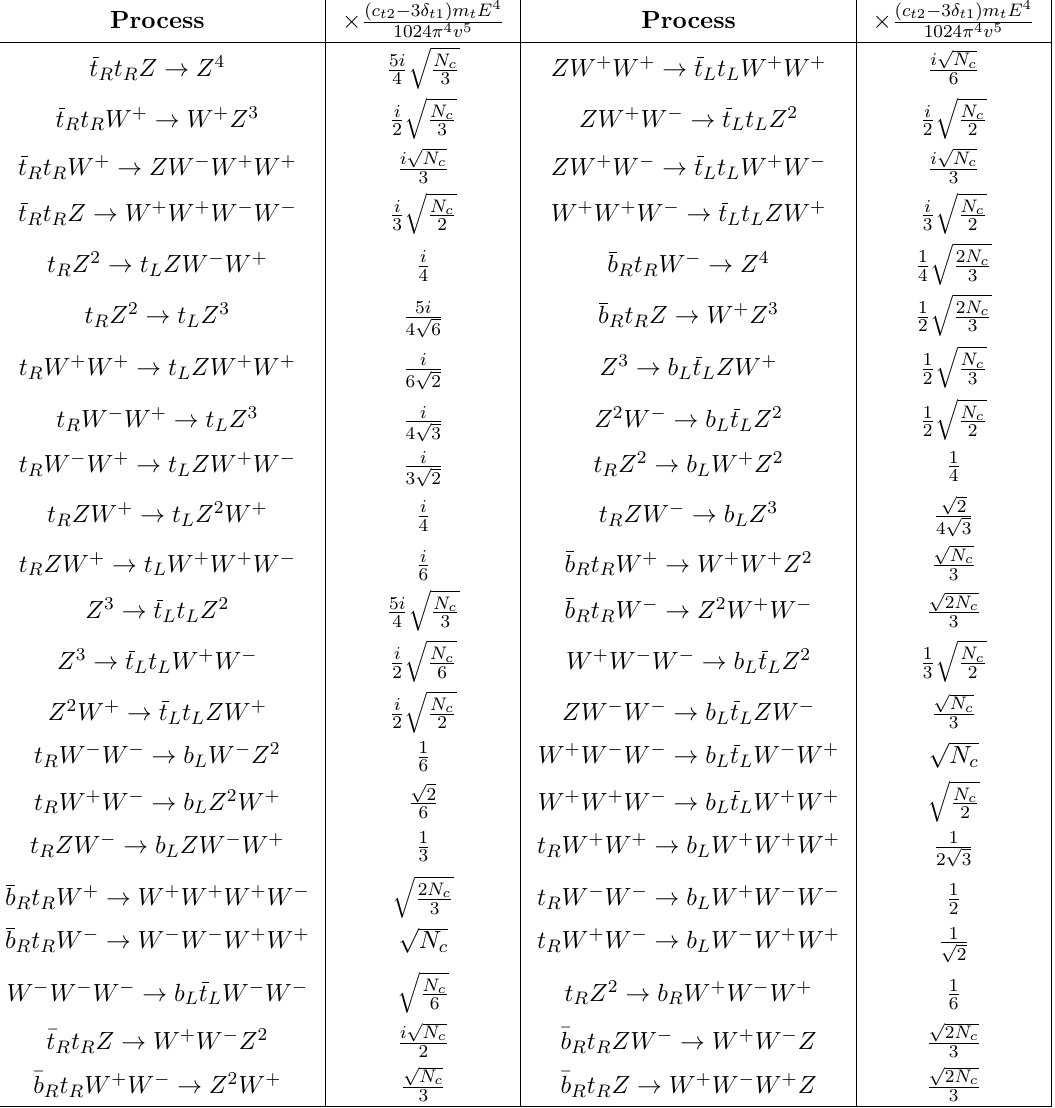
Table 10 . 7-body unitarity-violating processes that depend on c t 2 and δ t 1 . One can see that the dim-6 SMEFT prediction c = 3 δ gives vanishing amplitudes for all t 2 t 1